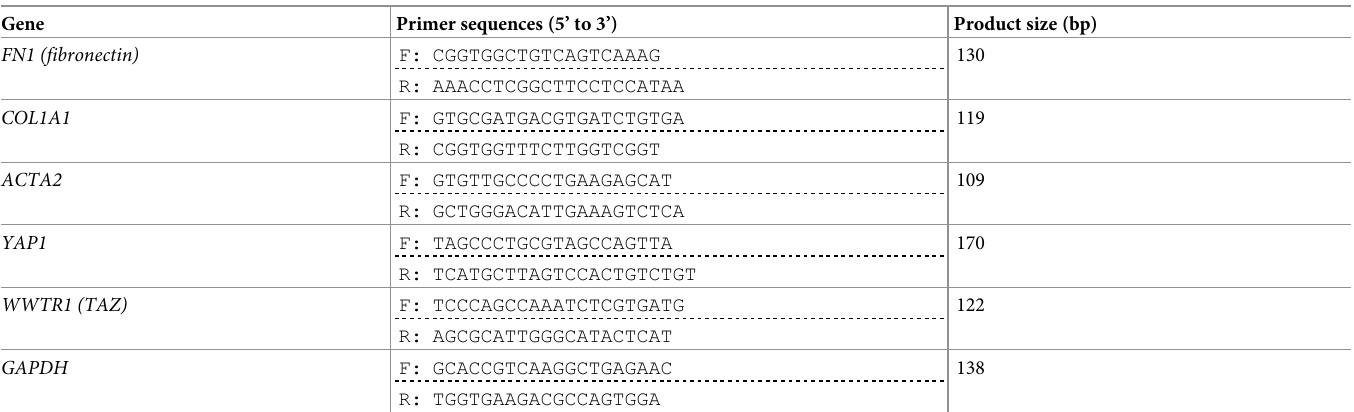
Table 1. Primer sequences in the quantitative